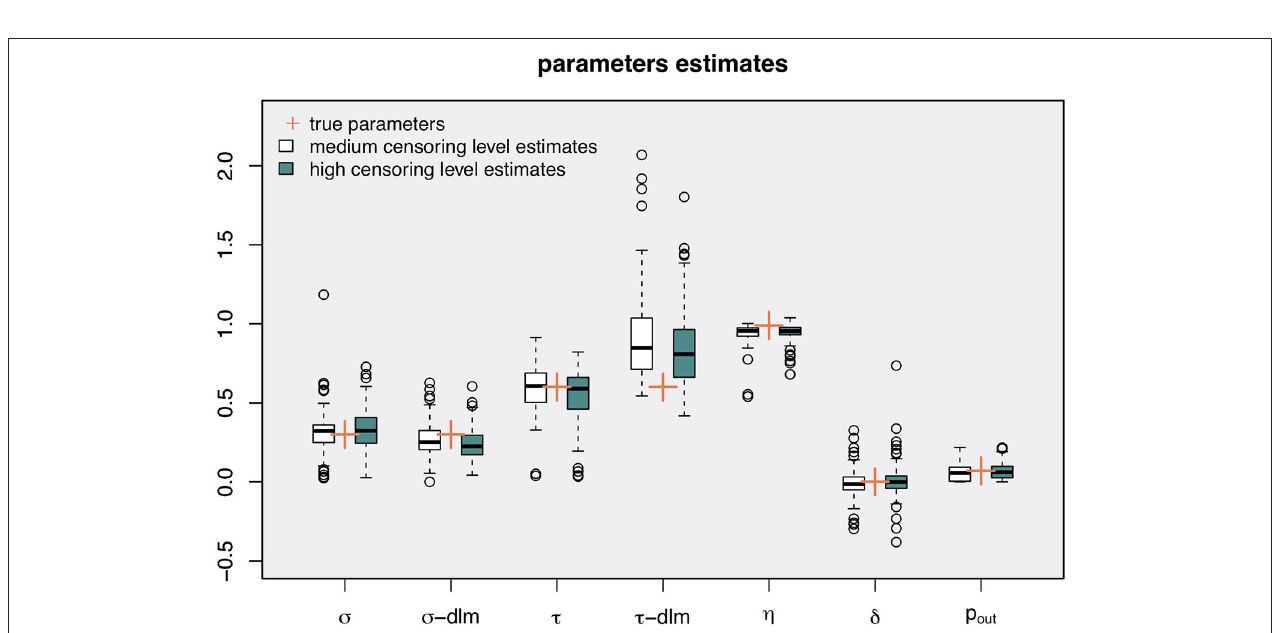
FIGURE 4 | Parameters estimates with our method ( σ , τ , η , δ ) and with a 2-parameter Kalman Smoother ( σ -dlm and τ -dlm) for 100 replicates of the simulation experiment (150 time steps, outlier rate of p = 7 % , observation rate of 50 % ), for 16 % and 31 % of censored data (respectively, white and cyan boxes).